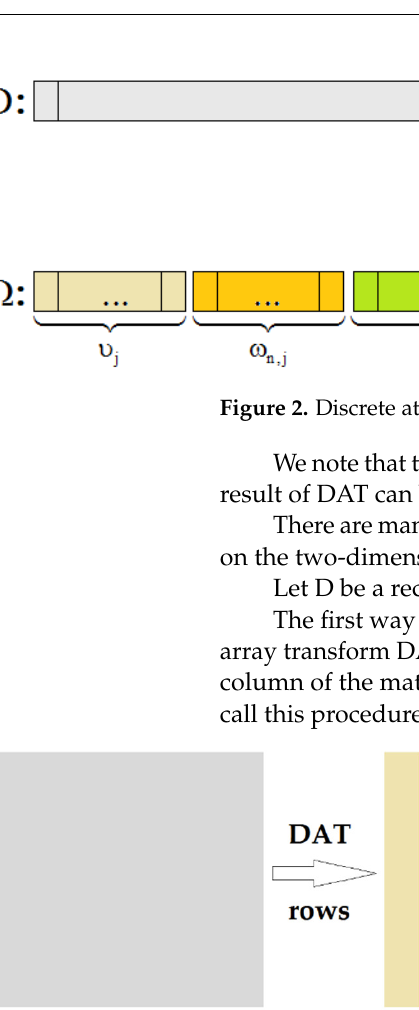
Figure 3. Discrete atomic transform of a matrix: the procedure DAT1.